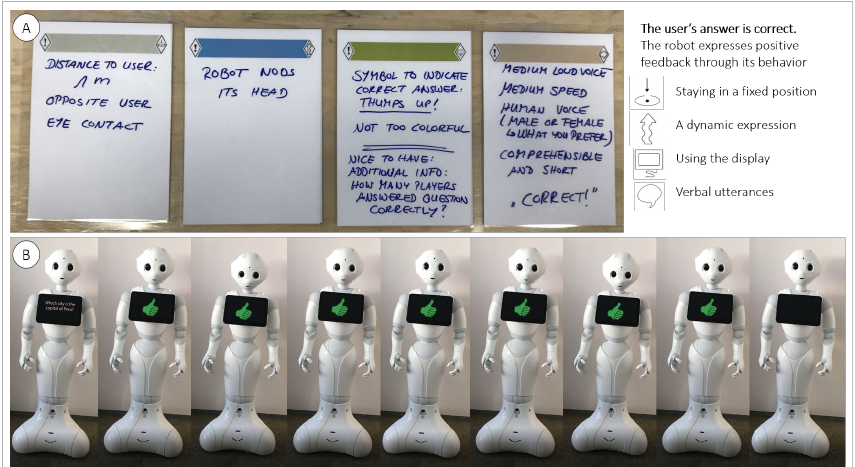
Figure 6. Example for a behavioral expression for the positive feedback situation: ( A ) Idea cards documenting the design solution. ( B ) Implementation on the Pepper robot.